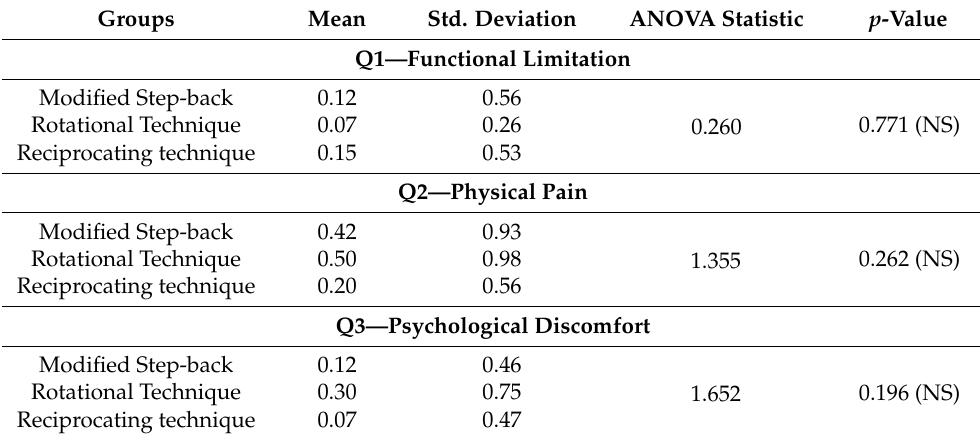
Table 2. Comparative evaluation of quality of life after